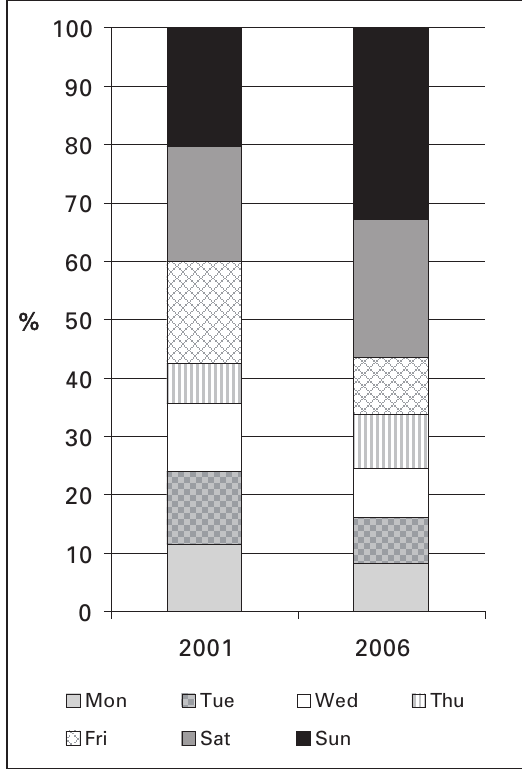
ED visits [%] between Mondays and Sundays in 2001 and